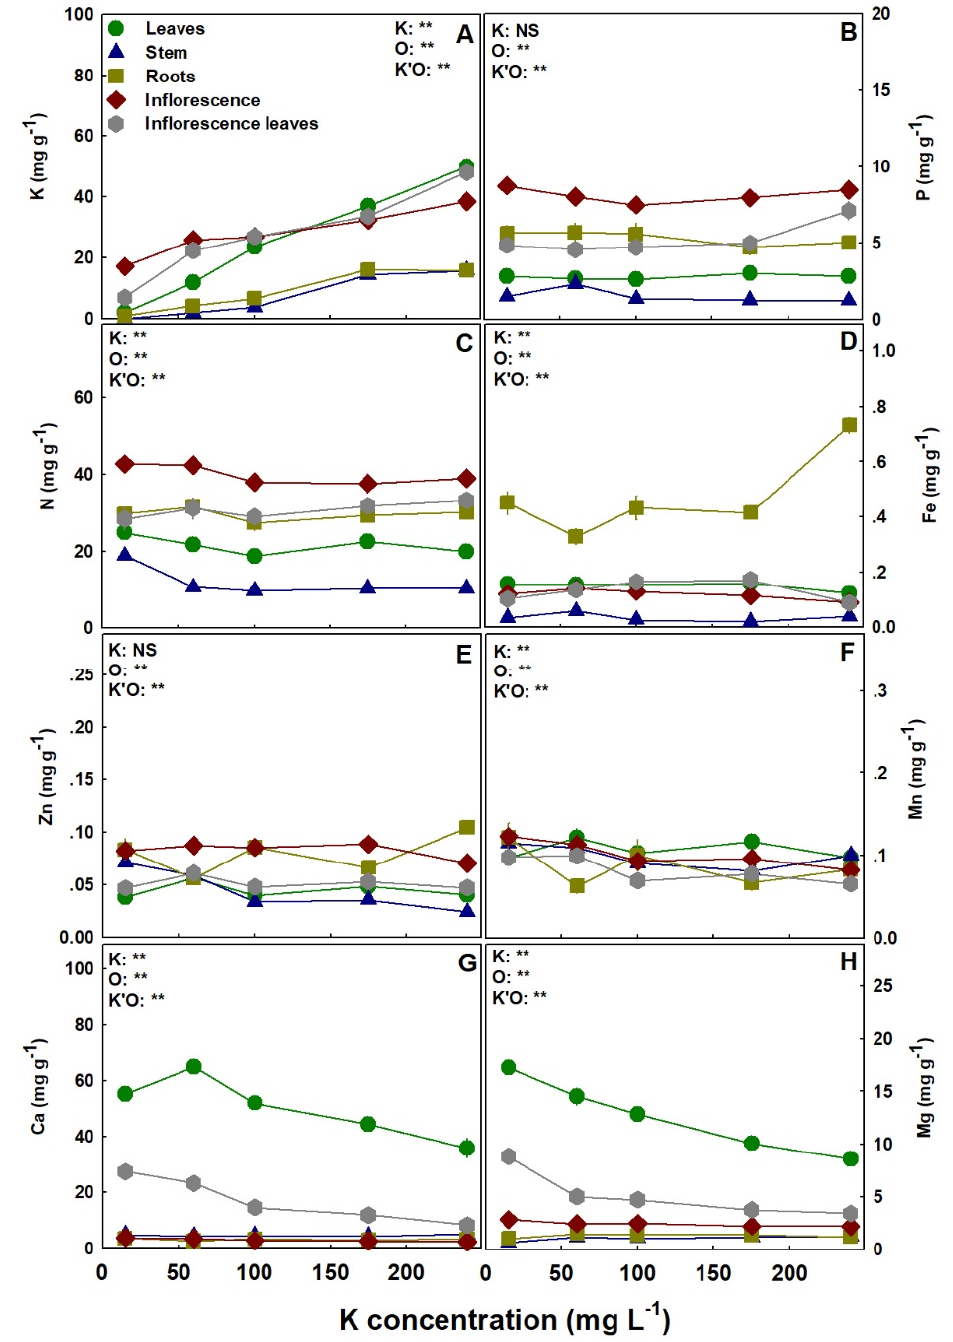
Figure 8. Effect of K supply on nutrient concentrations in the leaves, stem, roots, inflorescence, and inflorescence leaves of the medical cannabis cultivar DQ. K ( A ), P ( B ), N ( C ), Fe ( D ), Zn ( E ) Mn ( F ), Ca ( G ) and Mg ( H ). Presented data are averages ± SE ( n = 5). Where not seen, the error bars are smaller than the symbol size. Results of two-way ANOVA indicated as ** p < 0.05, F -test; NS, not significant p > 0.05 , F -test. In the ANOVA results, K’O represents the interaction between K and the plant organs.